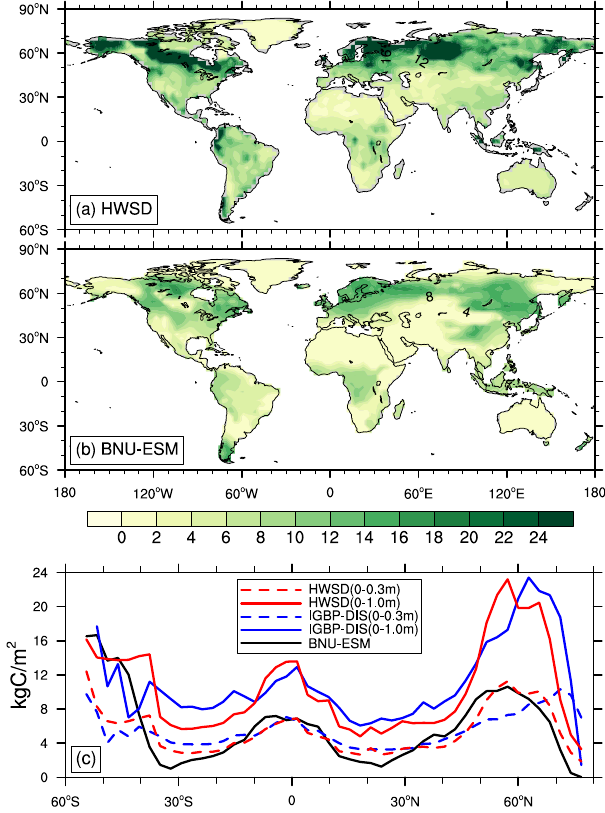
Figure 24. Soil-carbon density in the top 1m depth from the HWSD (a) and BNU-ESM (b) , and zonal average soil-carbon density of BNU-ESM compared with that of upper 0.3m and upper 1m soil from HWSD, IGBP-DIS data